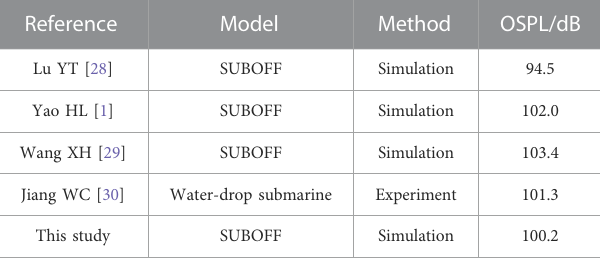
TABLE 1 Comparison between OSPL calculation results and relevant